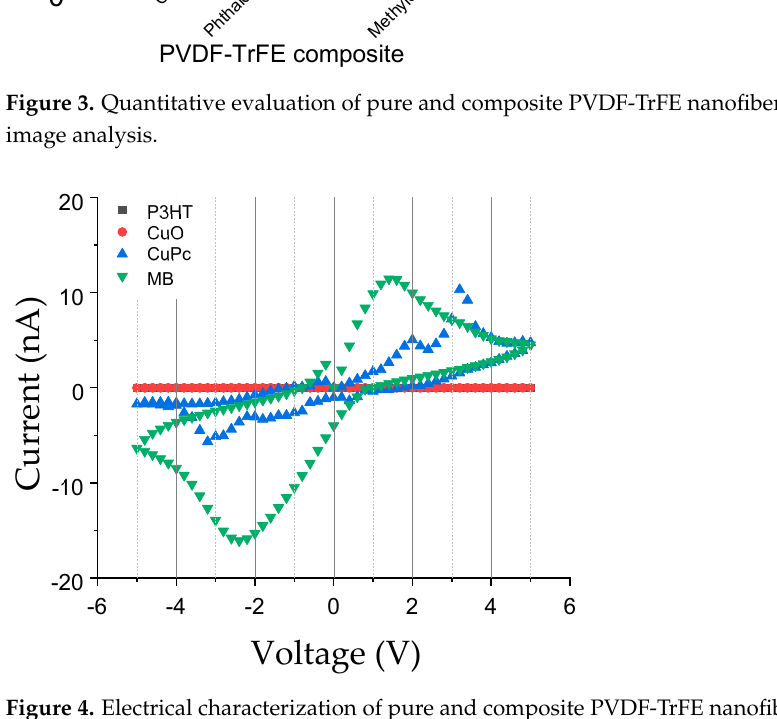
Figure 4. Electrical characterization of pure and composite PVDF-TrFE nanofibers: Current–voltage (I–V) curves as a function of different active components used.